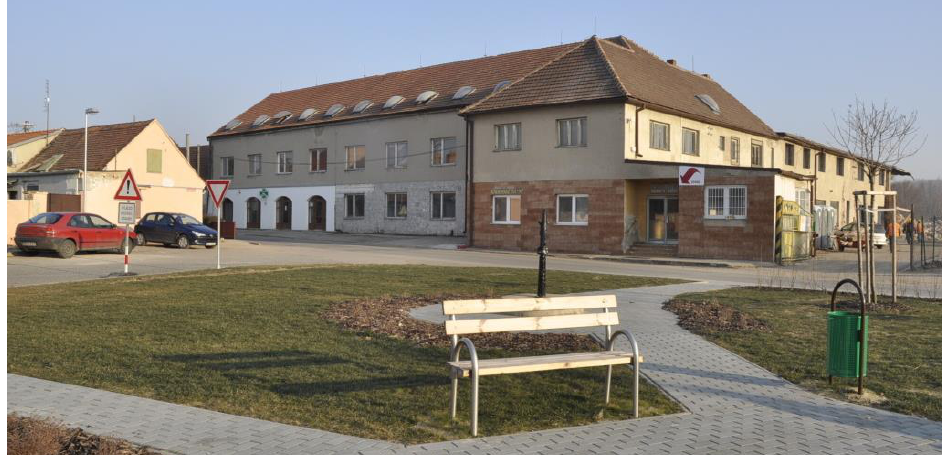
Figure 1. A view of the administrative building of the former socialist agricultural cooperative in Vranovice. Source: [58].